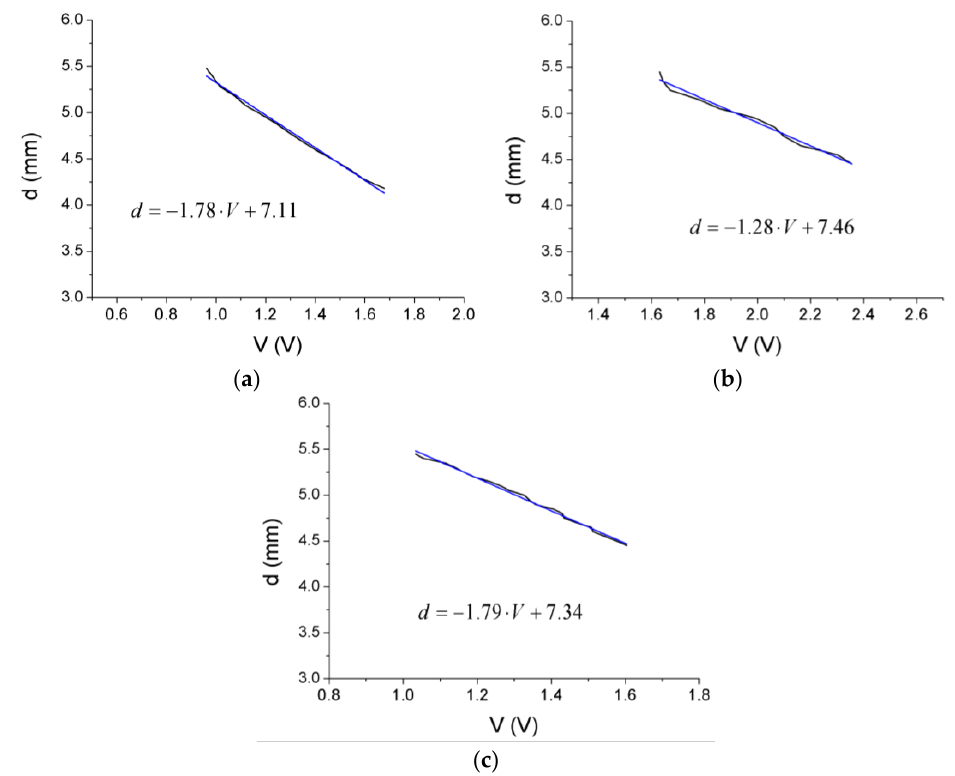
Figure 5. Calibration curve (black) and its linear fit (blue) for OFS 1 ( a ), OFS 2 ( b ) and OFS 3 ( c ) for the measuring interval.